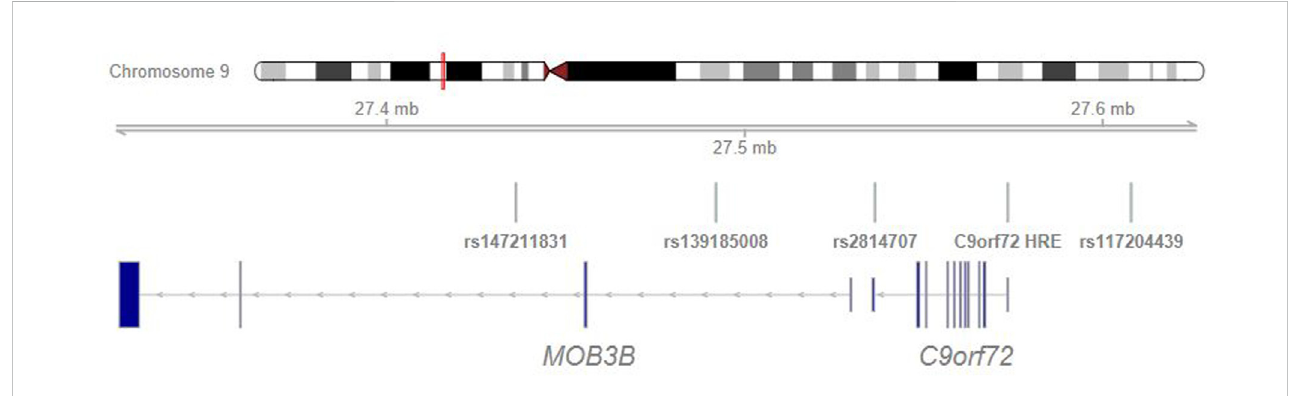
FIGURE 2 C9orf72 intermediate allele and expansion tagging SNP